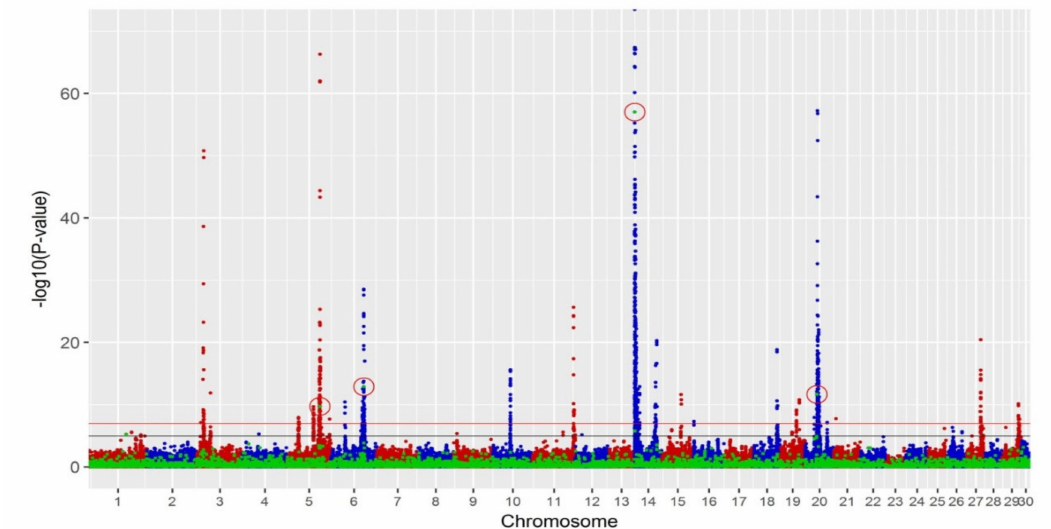
Figure 3. Manhattan plots of production multi-trait meta-analysis with − log 10 ( p -value) on the vertical axis and chromosome number on the horizontal axis. The red line is the threshold of p -value 10 − 7 , and the black line is the threshold of p -value 10 − 5 . Blue and red dots represent SNP markers, and green dots represent SV markers. Significant SVs with p -value < 10 − 7 are circled in red. SNPs with p -value less than 10 − 70 were not